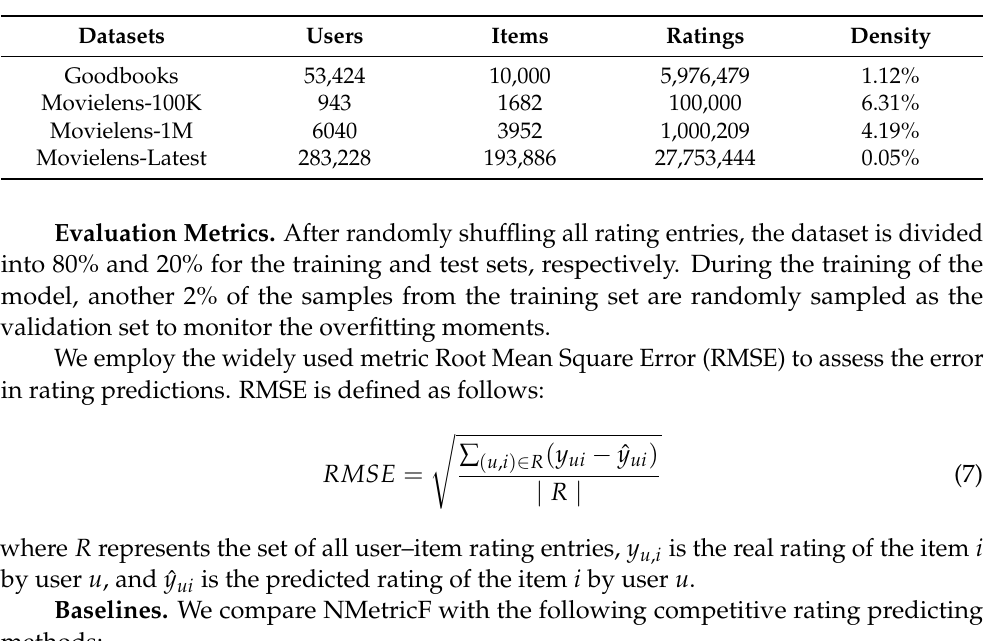
Table 1. Statistics of four datasets (# denotes “Number